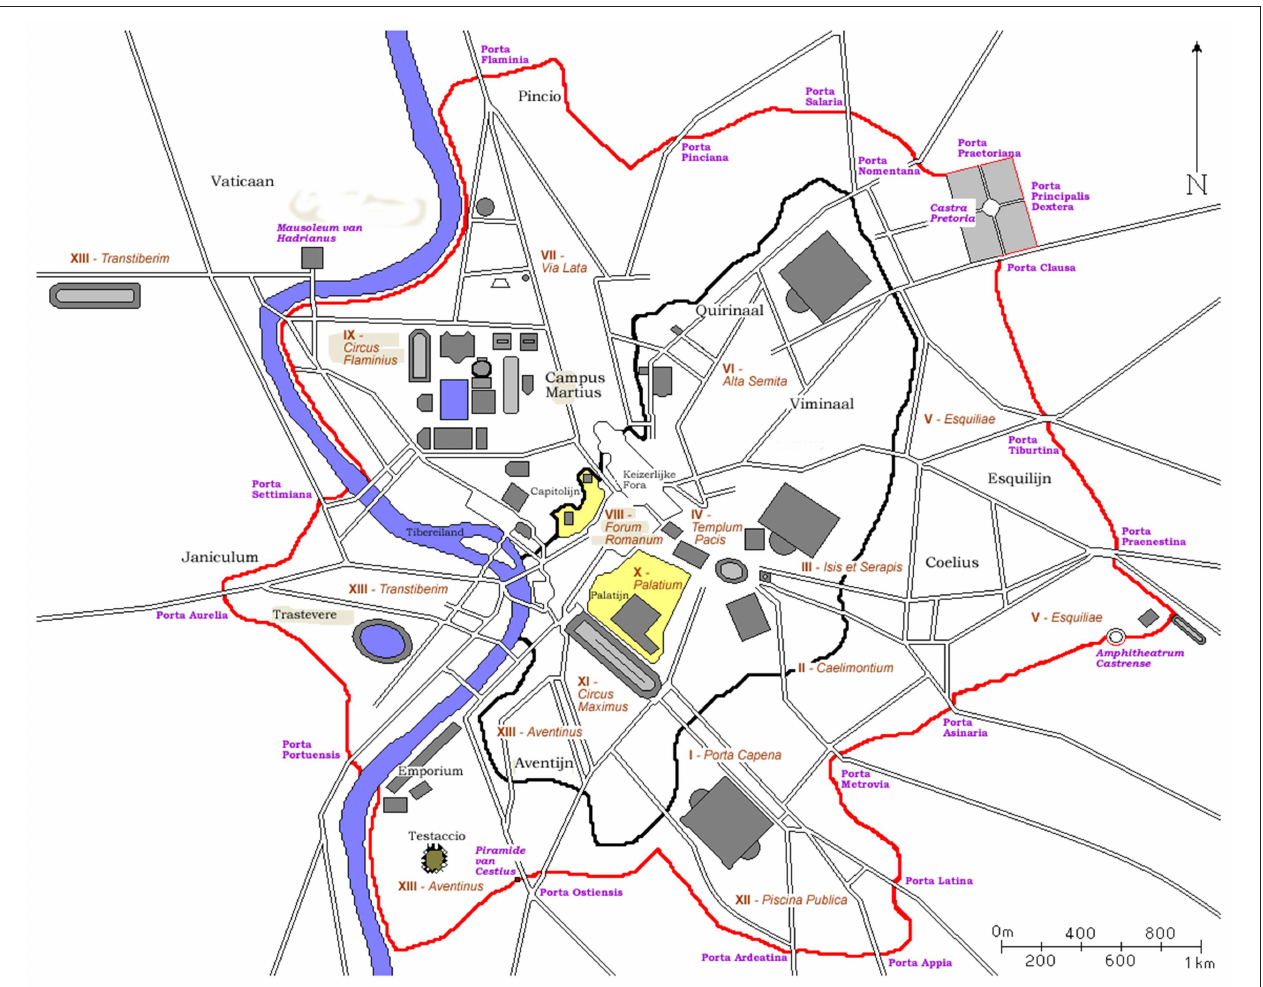
FIGURE 10 | Map of Rome showing Republican and Aurelianic Walls. NB: Location of main roads; Porta Asinaria and Porta Tiburtina ; the Castra Pretoria; and the Amphitheatrum Castrense (https://commons.wikimedia.org/wiki/File:Plan_Rome-_Aureliaanse_Muur.png) (Joris1919) [CC BY-SA 3.0 (http://creativecommons.org/